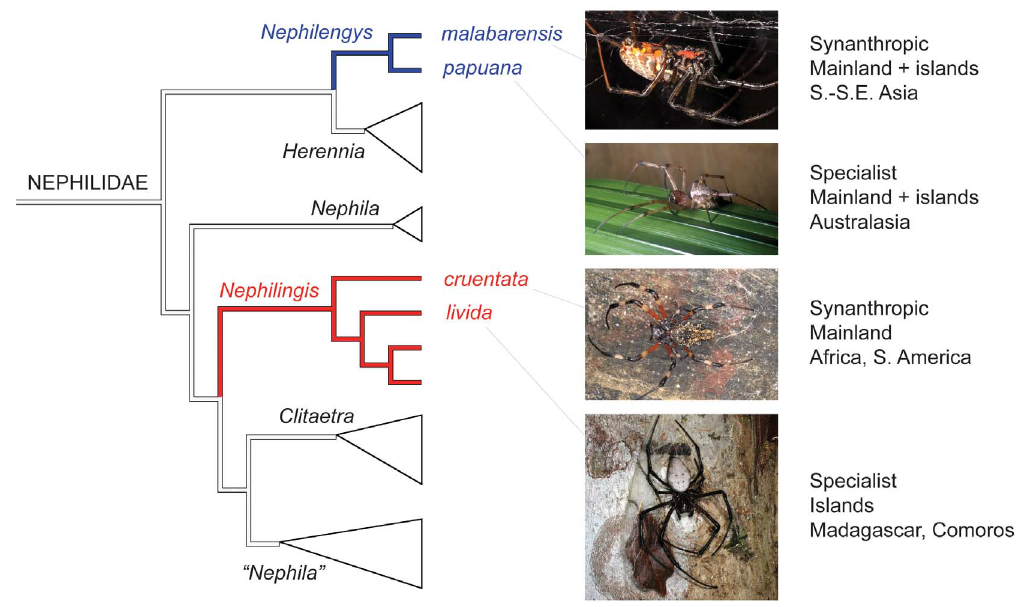
Figure 1. Two nephilid species pairs, their phylogeny, and basic ecology. One species from each clade is synanthropic and the other one a habitat specialist. This sample tests the relative importance of phylogeny versus life history on species responses to climatic changes. The phylogenetic hypothesis builds on a nephilid species level study that used 4kB of nucleotide data in addition to morphology, and an array of analytical approaches and sensitivity analyses